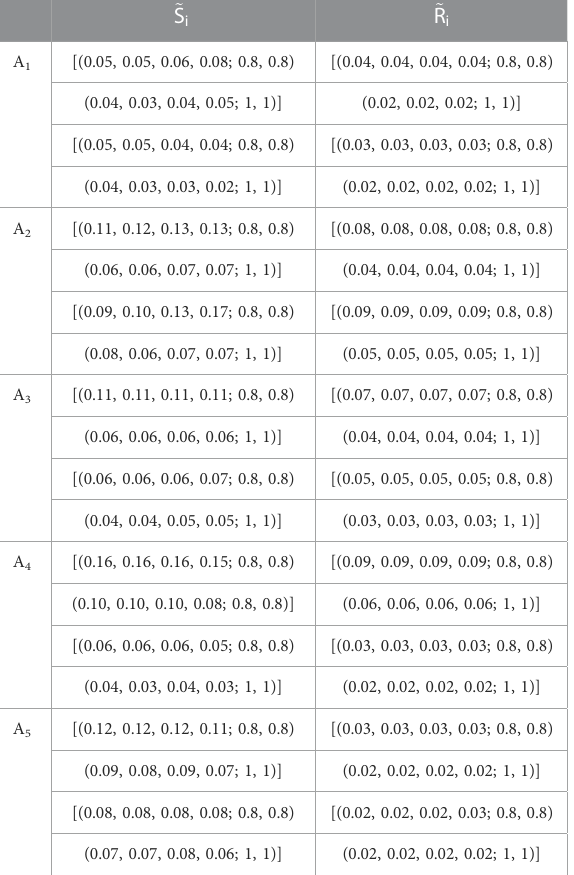
TABLE 11 ~ S i and ~ R i